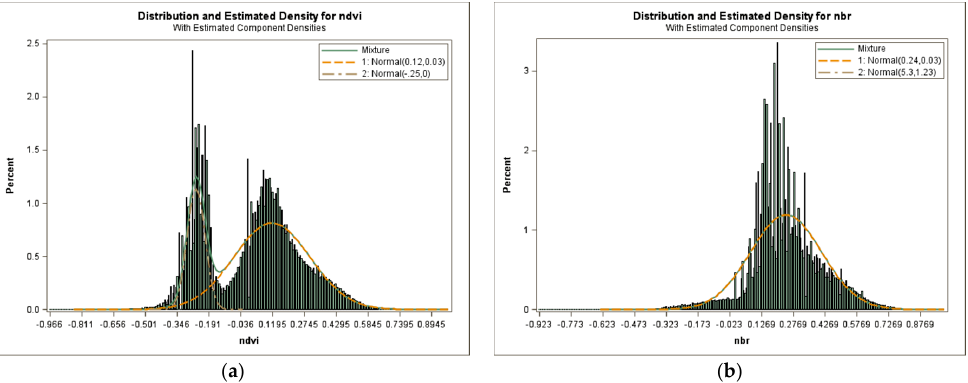
Figure 5. Histograms of spectral index values for the Florida Everglades 4800-by-5200 pixels image. ( a ) NDVI; and ( b ) NBR.